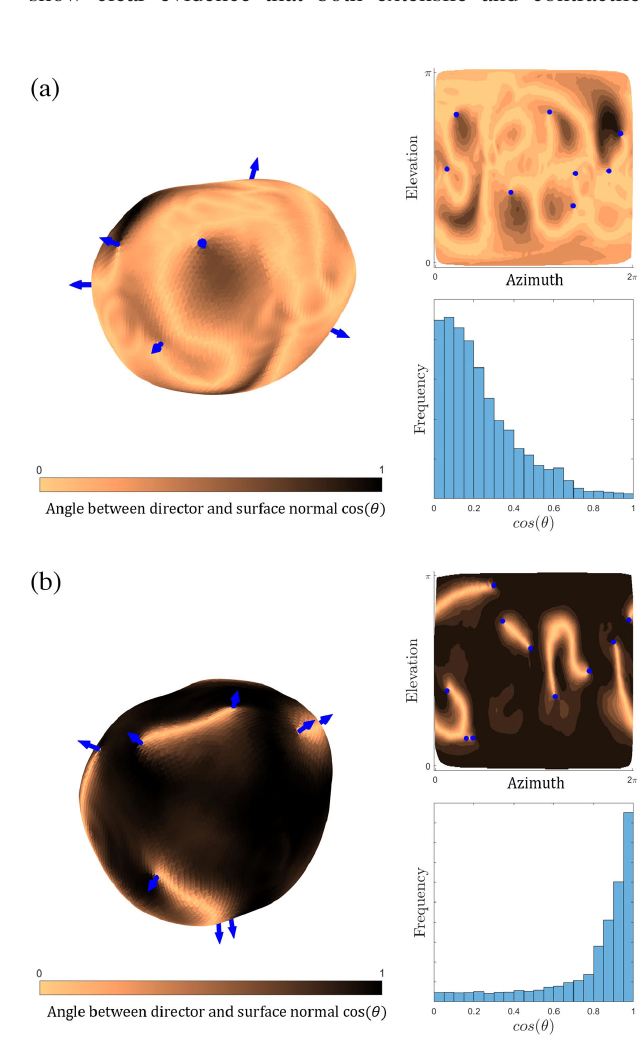
FIG. 3. Surface alignment of the director field for extensile (a) and contractile activity (b). Surface defects, shown as blue arrows, are connected via disclination lines running through the bulk. The surface alignment is indicated by the color bar, where orange (black) indicates in-plane (perpendicular) director alignment with respect to the interface. Upper right: surface alignment in projection. Lower right: distribution of surface angle cos ð θ Þ over the total surface